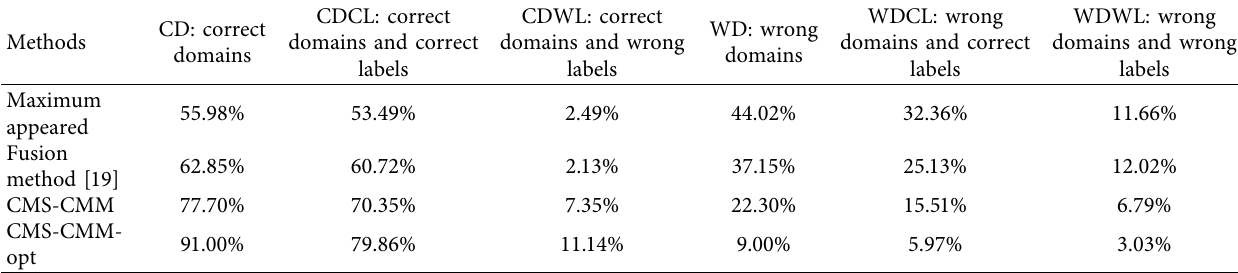
Table 5: Evaluation by more metrics on all testing